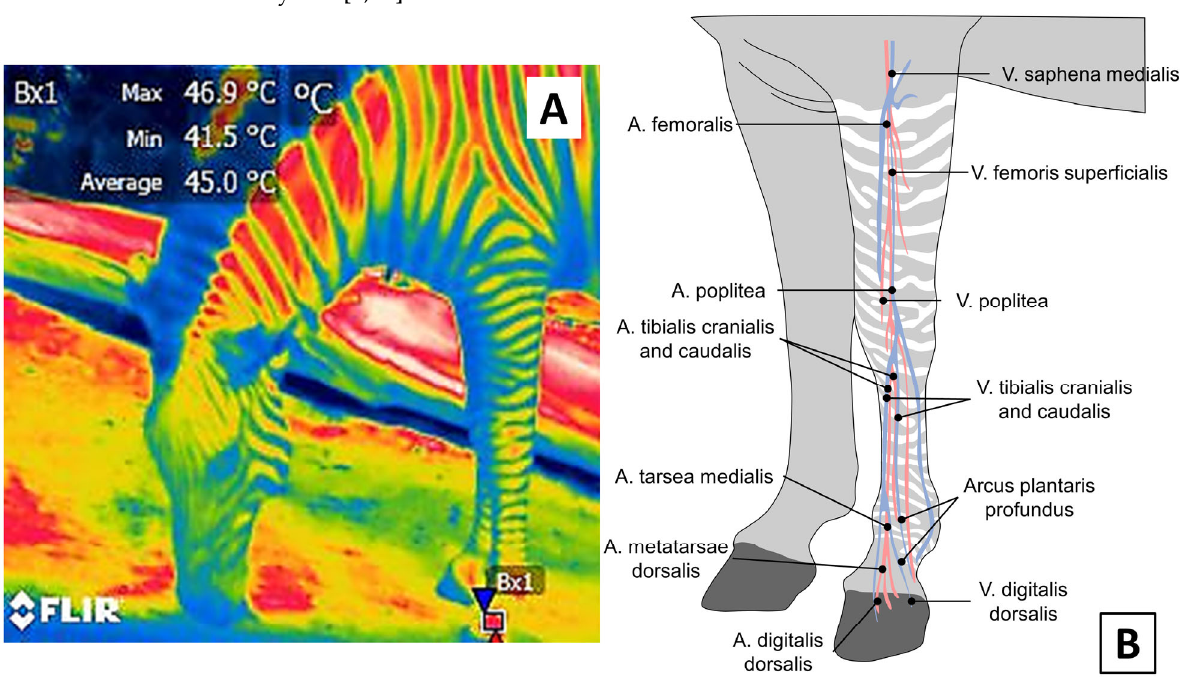
Figure 10. Podal window. ( A ). The podal region assessed using a rectangle that proximally encompasses the metacarpophalangeal joint down to the distal phalanx. ( B ). This window has been used to detect inflammatory processes in paws that generate the secretion of pro-inflammatory substances and, consequently, greater heat radiation.